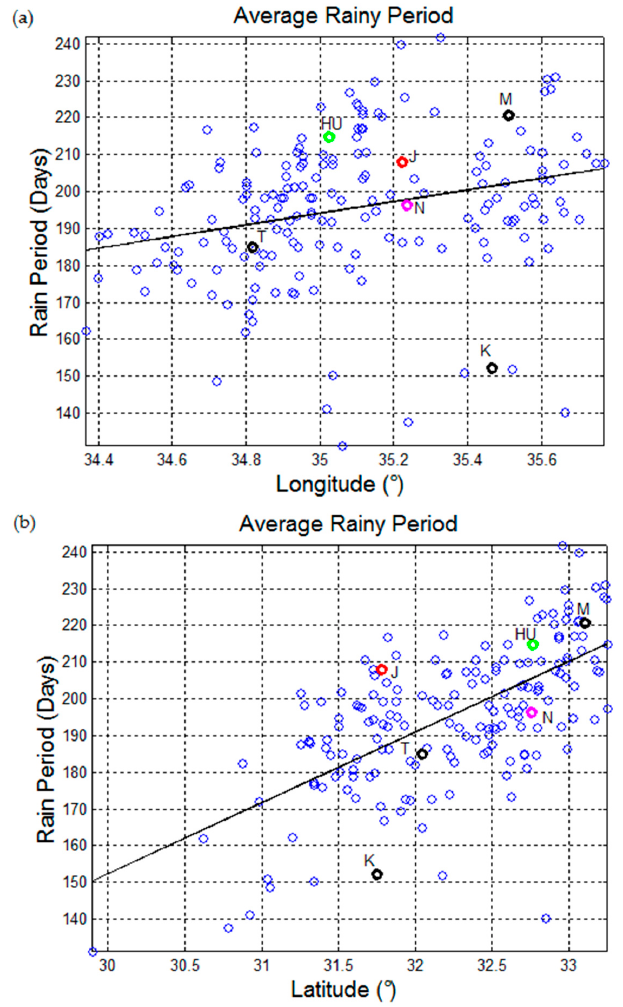
Figure 2. Annual average value of the rainy period for 184 localities of the Holy Land versus longitude (a) and latitude (b), from 1990 to 2015, according to the IMS. Explicitly indicated are the values of Jerusalem (J), Tel Aviv (T), Haifa University (HU), Nazareth (N), Malkiya (M), Kalya (K).